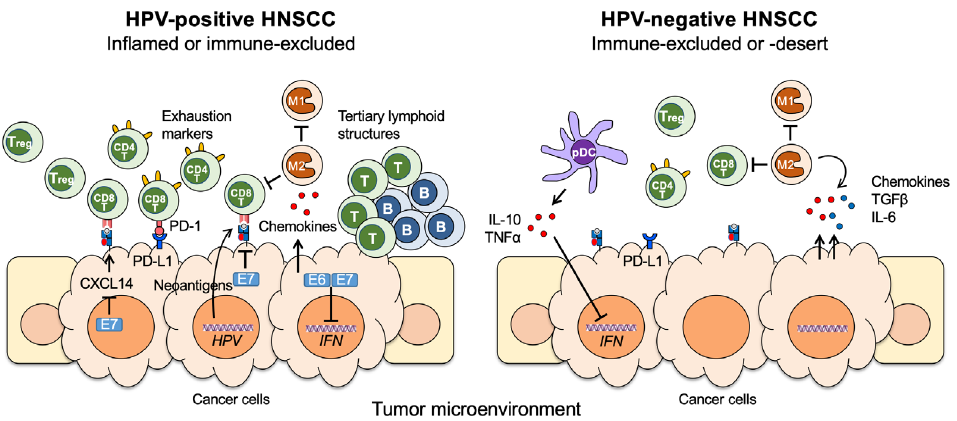
Figure 2. A summary of immune dysregulation and evasion in the tumor microenvironment (TME) of HPV+ (left) and HPV− (right) HNS CCs. The differential immunophenotypes in the TME between HPV+ and HPV− HNSCC are depicted, based on three different spatial distribution of CD8 + T